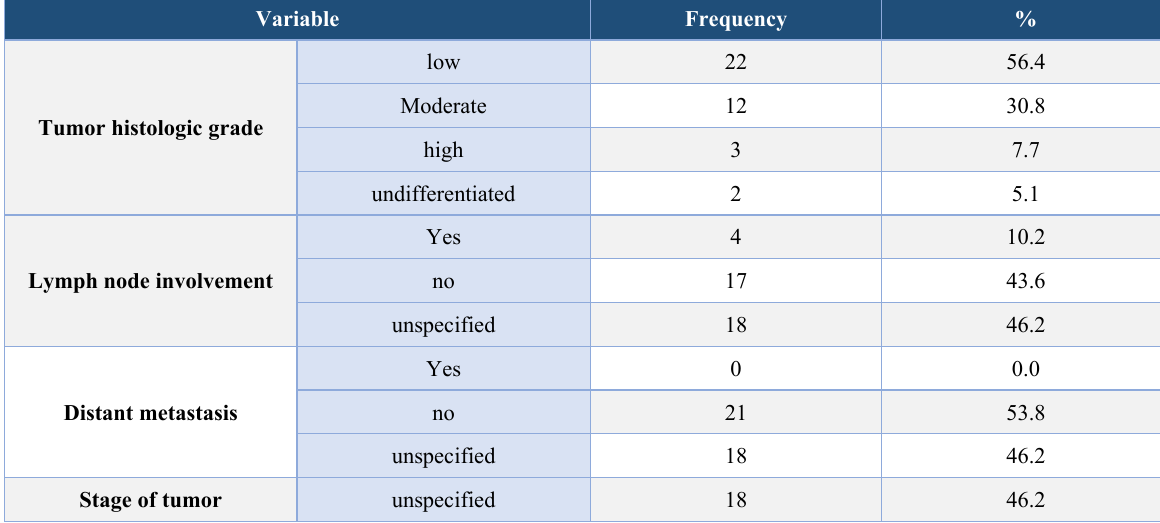
Table 3 .Evaluation of pathologic parameters of head and neck